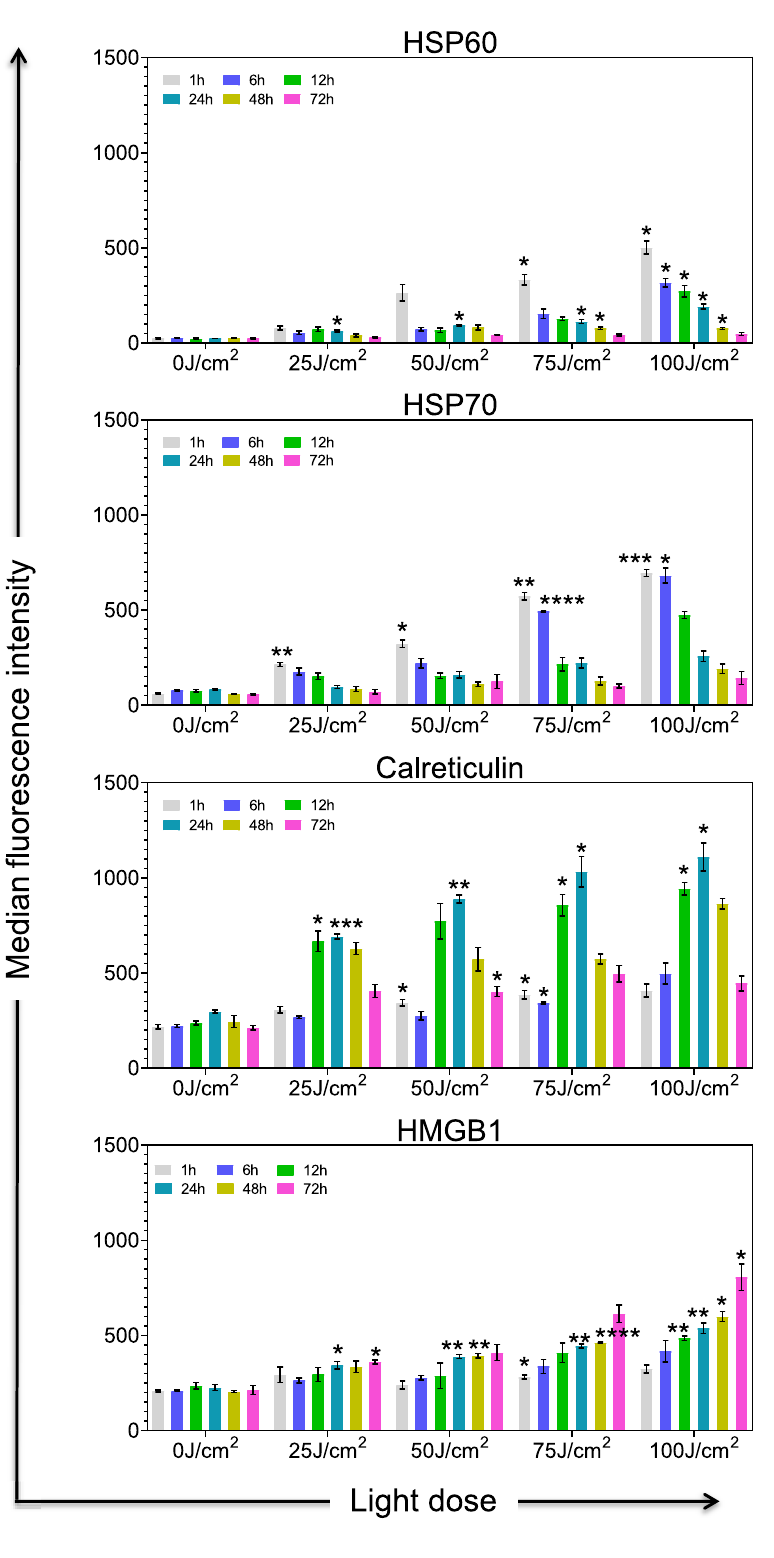
Figure 4: Expression of TR-PINs induced bio- logical markers of immunogenic cell death in Panc spheroid cultures. NIR activation of TR-PINs induces cell surface exposure of Hsp60, Hsp70, Calreticulin, and the intracel- lular expression of HMGB1 inPanc(MIA PaCa-2 andPCAF)spheroidculturesinalightdoseand time-dependent manner. Data are representa- tive of three independent experiments done in duplicates.ExpressionlevelsofHsp60,Hsp70, Calreticulin, and HMGB1 were determined by flow cytometry calculated as the median fluo- rescenceintensity(MFI)aftersubtractionofthe isotypecontrolsMFIat1,6,12,24,48,and72h after NIR activation of TR-PINs. Graphs with error bars indicate mean ± SEM from three in- dependent experiments. Statistical signi fi - cance was determined by a one-way ANOVA and Tukey's posthoc test. Asterisks denote statistical signi fi cance (* P < 0.05, ** P < 0.005, *** P < 0.0005, **** P < 0.00005). The NIR photodynamic activation regimen used was 690 nm light irradiation with 25 or 50 or 75 or 100 J/cm 2 at 150 mW/cm 2 . Two hundred and fi fty Newton-meters of TR-PINs (BPD-PC equiv- alent) were